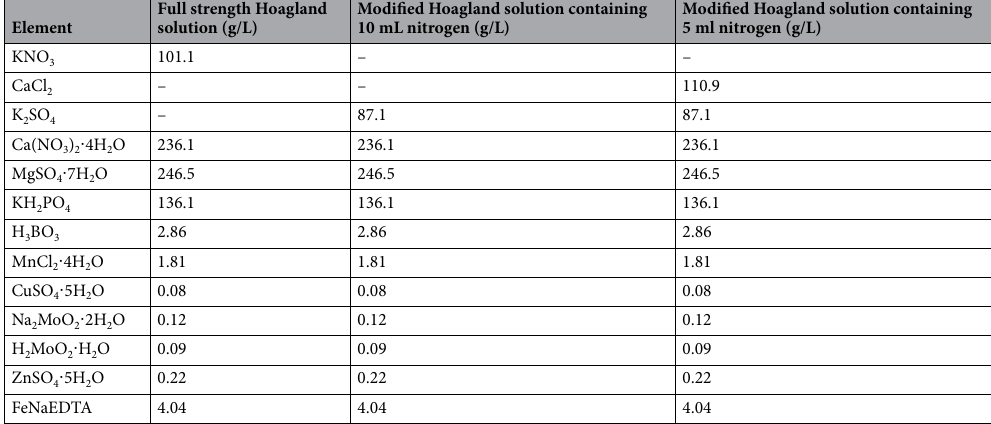
Table 1. The composition of nutrient solutions of different N levels were modified based on a full-strength Hoagland